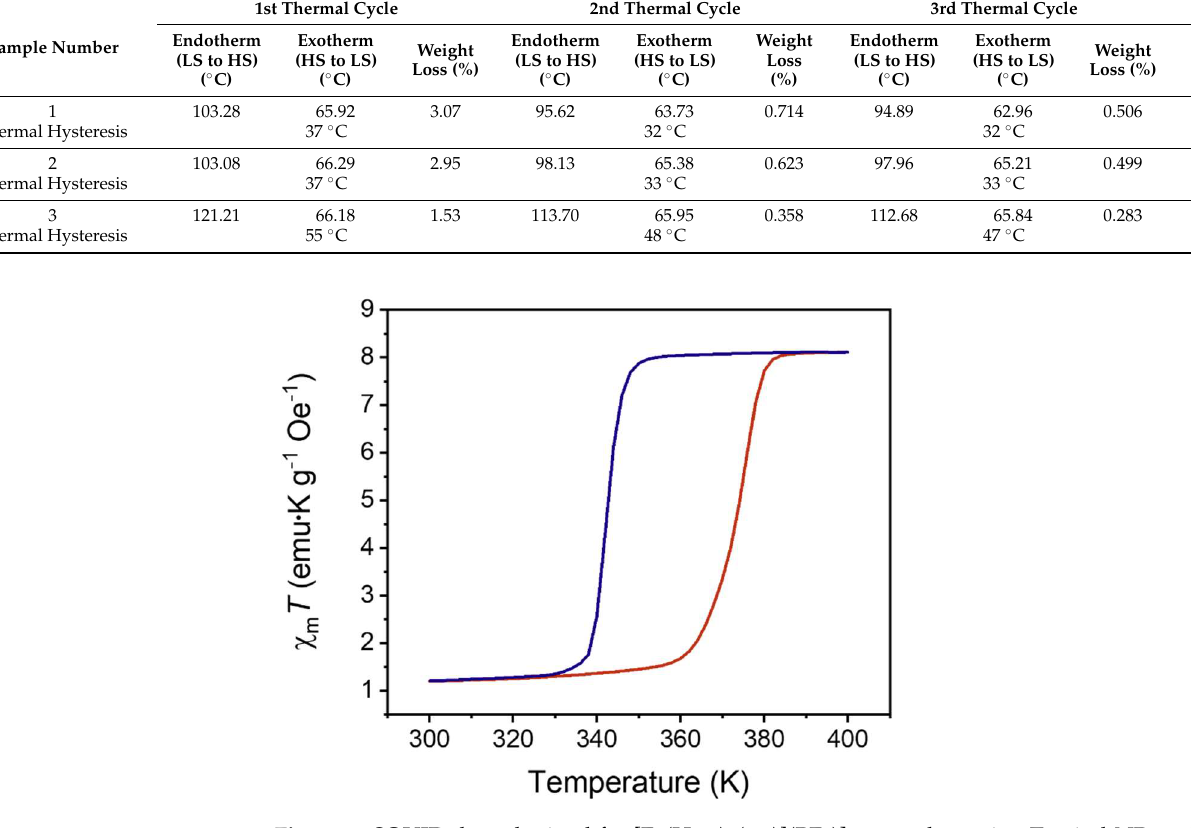
Figure 7. SQUID data obtained for [Fe(Htrz) 2 (trz)](BF 4 )] nanocubes using Tergitol-NP surfactant. Sample was held under a constant magnetic field of 1000 Oe. Initial transition from low to high spin state can be seen starting at 355 K. High to low spin transition occurred at 345 K which then stabilized at 335 K.